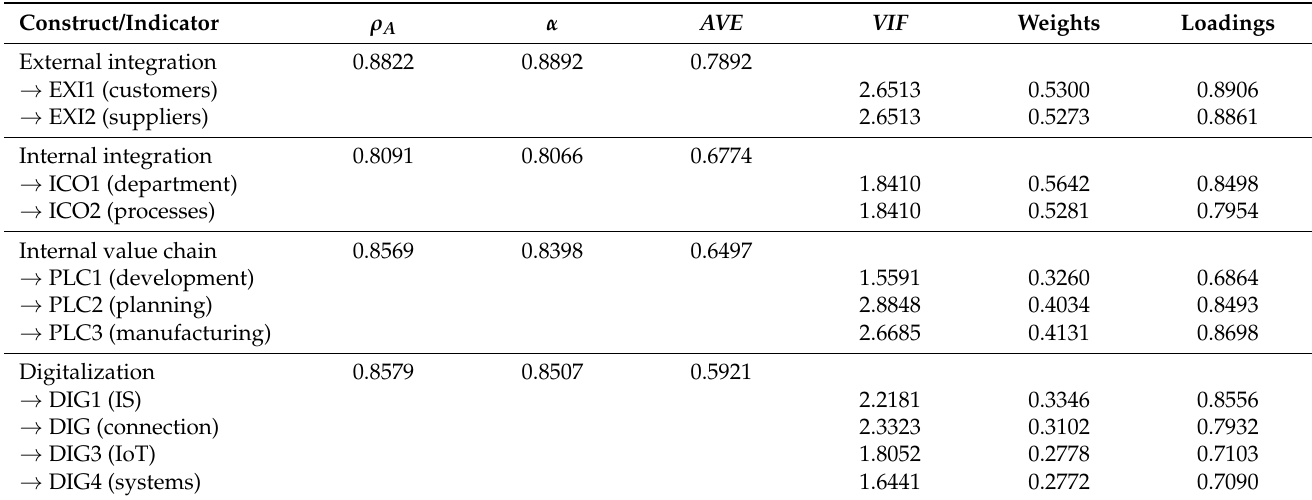
Table 1. Measurement model evaluation of validity, reliability, weights, and